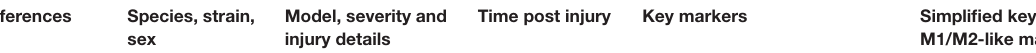
Simplified key results of M1/M2-like marker